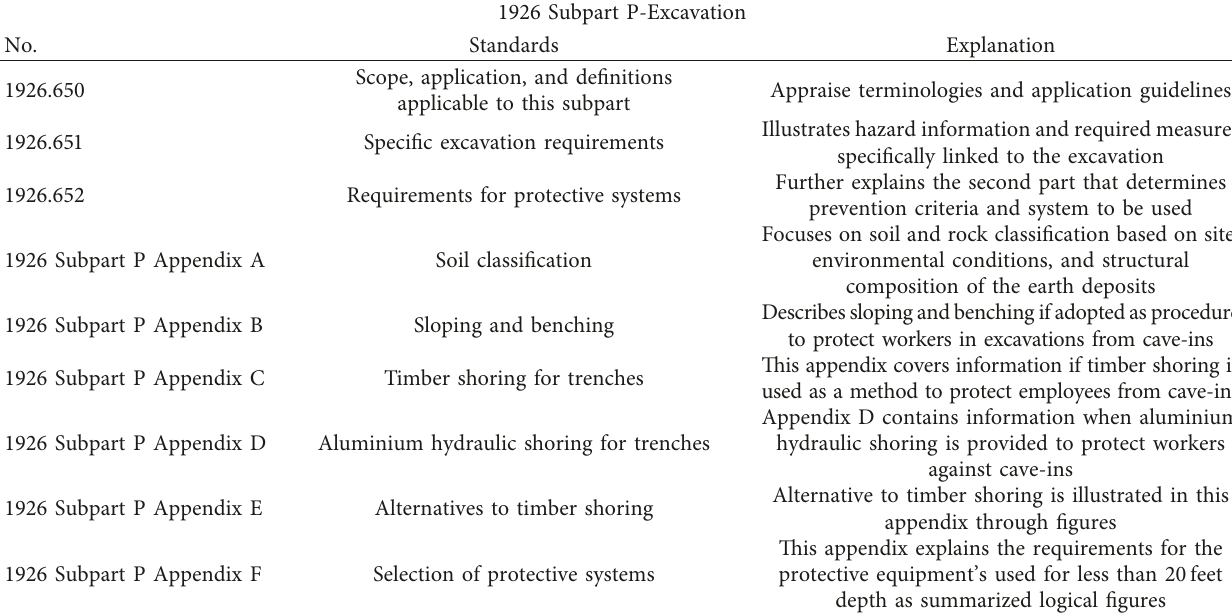
Table 1: Excavation-related OSHA rules.